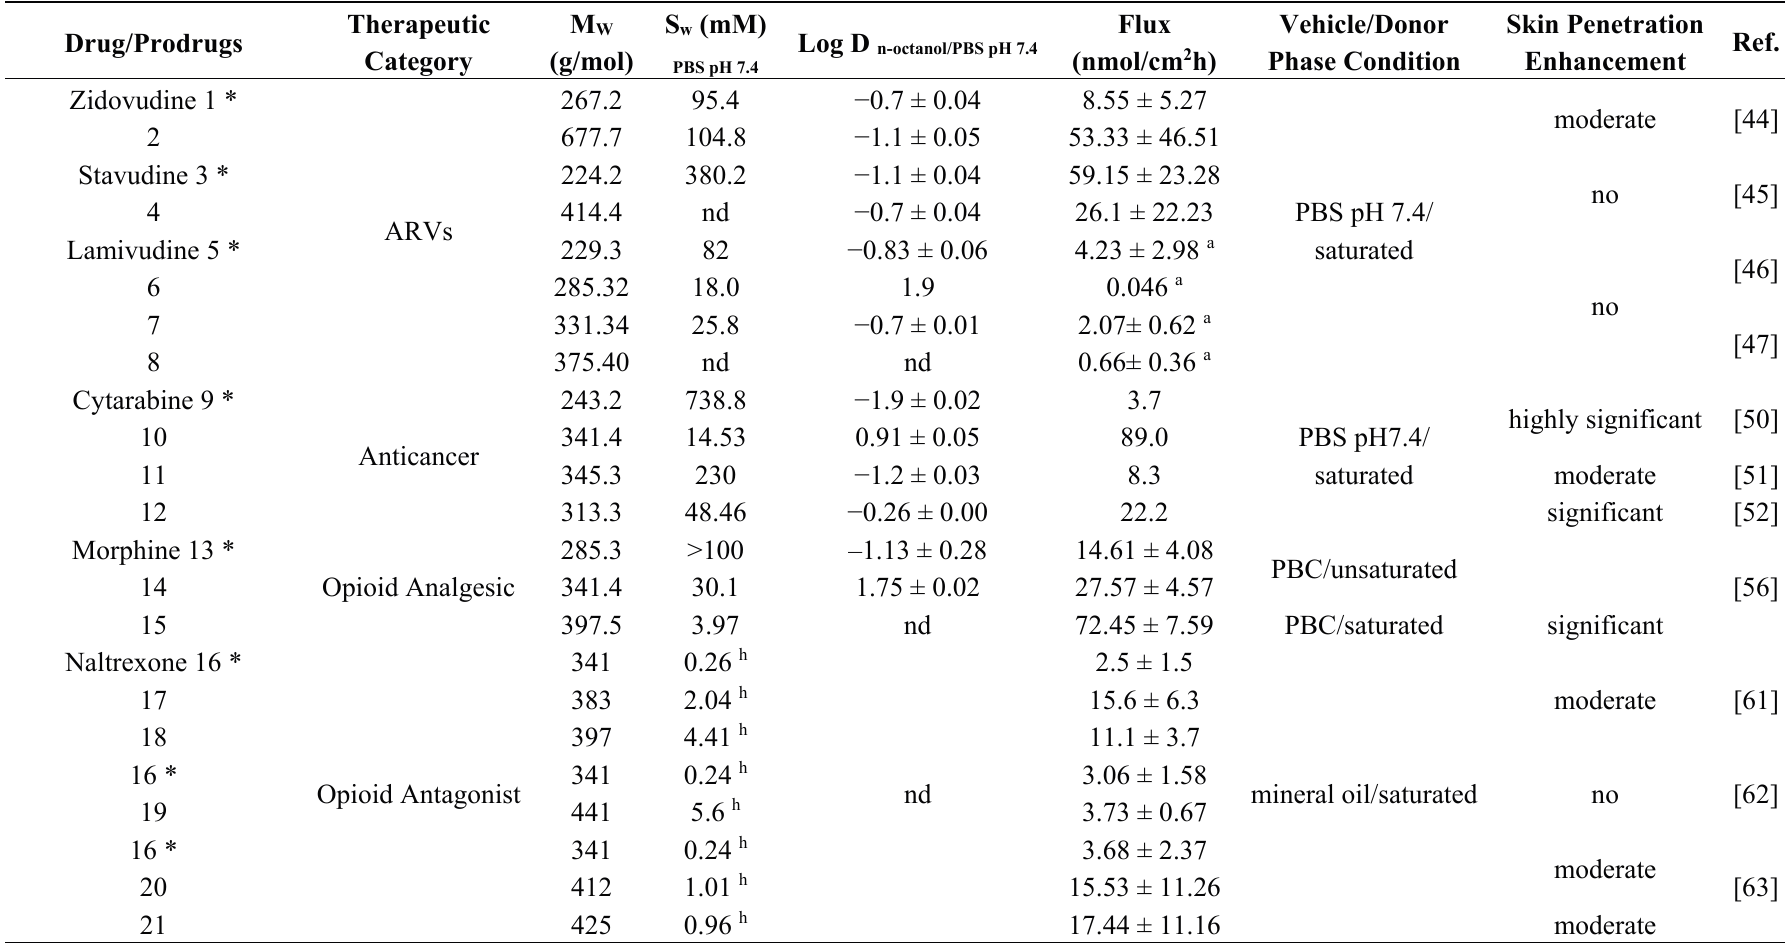
Table 1. Physiochemical data and skin permeation fluxes of all parent drugs and best percutaneous penetrant derivatives.